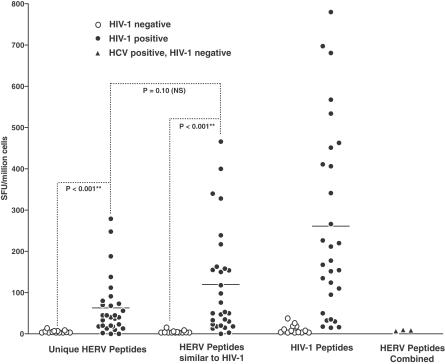
T Cell Responses to HERV and HIV-1 Antigens in HIV-1-Positive and -Negative Individuals Measured by Interferon-γ ELISPOTHERV peptides were grouped according to their similarity to HIV-1 peptide sequence, with “Unique HERV Peptides” having three or fewer amino acids in common with an HIV-1 peptide, and “HERV Peptides Similar to HIV-1” having four or more peptides in common with HIV-1. Subsets of peptides were tested in each patient, with the number tested (n = 6–23) varying depending on HLA type. Values shown for responses are normalized per peptide within each grouping (i.e., the sum of the response values to all peptides tested divided by the number of peptides tested for each patient). The individual peptide responses that are summarized in this figure are detailed in Figure S3. Responses in HIV-1-positive individuals are shown as closed circles and in HIV-1-negative individuals as open circles. Responses to all HERV peptides were measured for HCV+ individuals and are shown as filled triangles. p-Values are derived from the Mann-Whitney test.